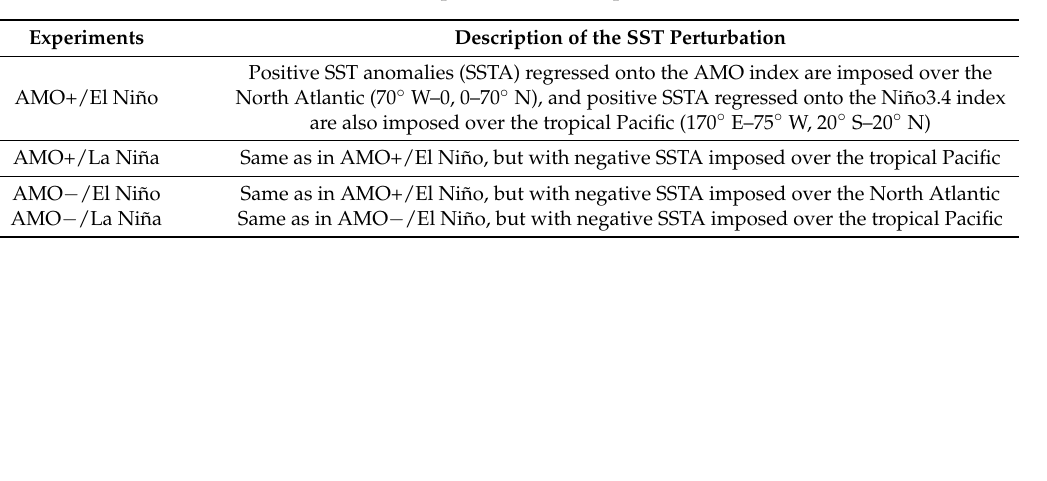
Table 1. List of the perturbed-SST